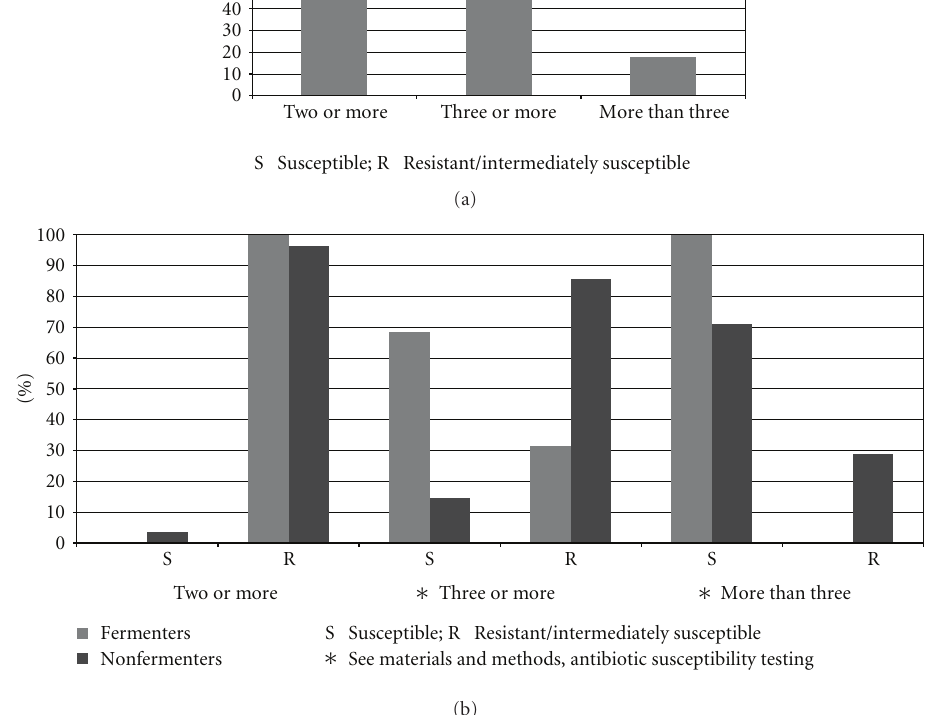
Figure 2: (a) Percent distribution among the 134 resistant Gram negative bacterial strains of resistance (including intermediate susceptibility) to at least two, at least three, and more than three antibacterial drugs. (b) Comparison between frequency of resistance to at least two, at least three, and more than three antibacterial drugs in Gram negative fermenters and nonfermenters.